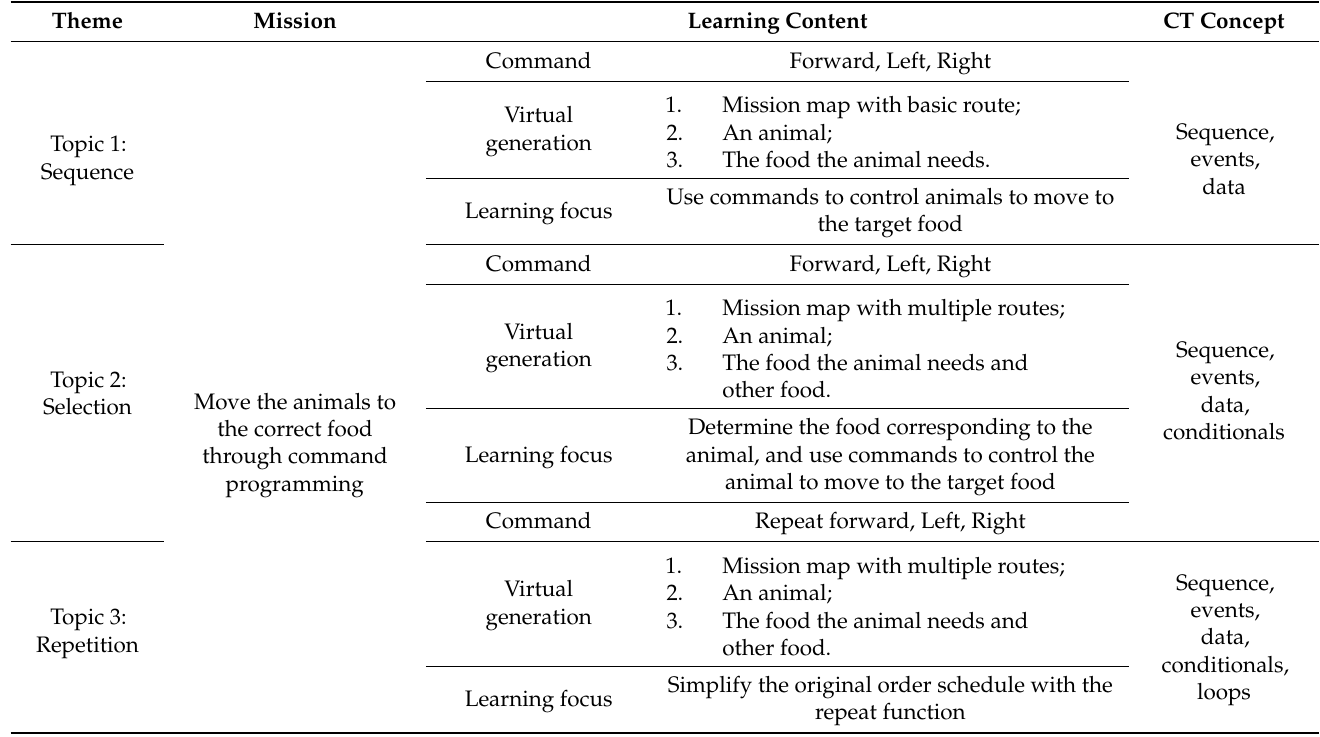
Table 3. Curriculum Structure Table.